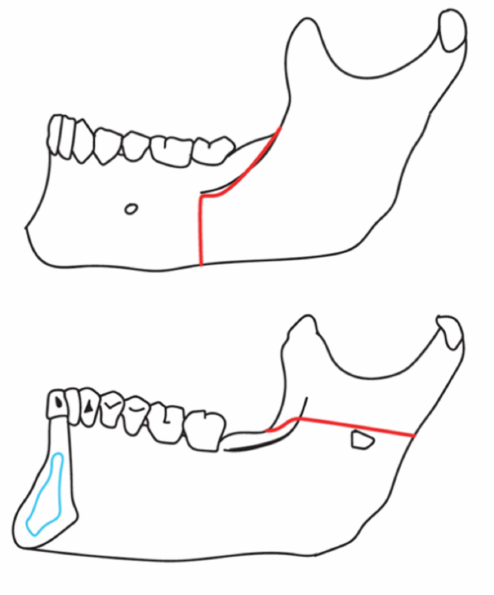
Figure 2. Schematic view of sagittal mandibular osteotomy modo Obwegeser–Dal-Pont.